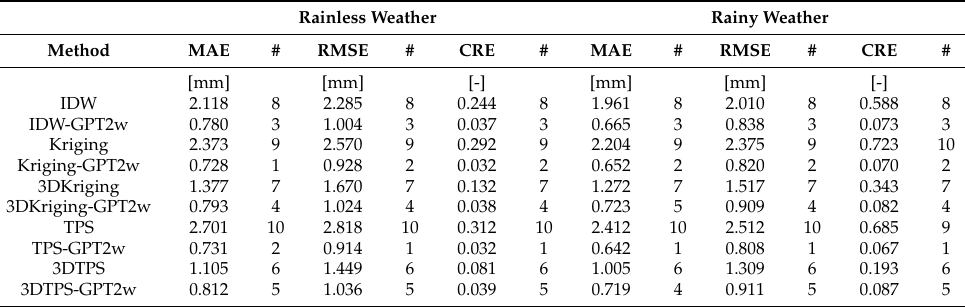
Table 1. Summary of the performance evaluation of di ff erent interpolation schemes for station cross-validation (left for rainless and right for rainy weather